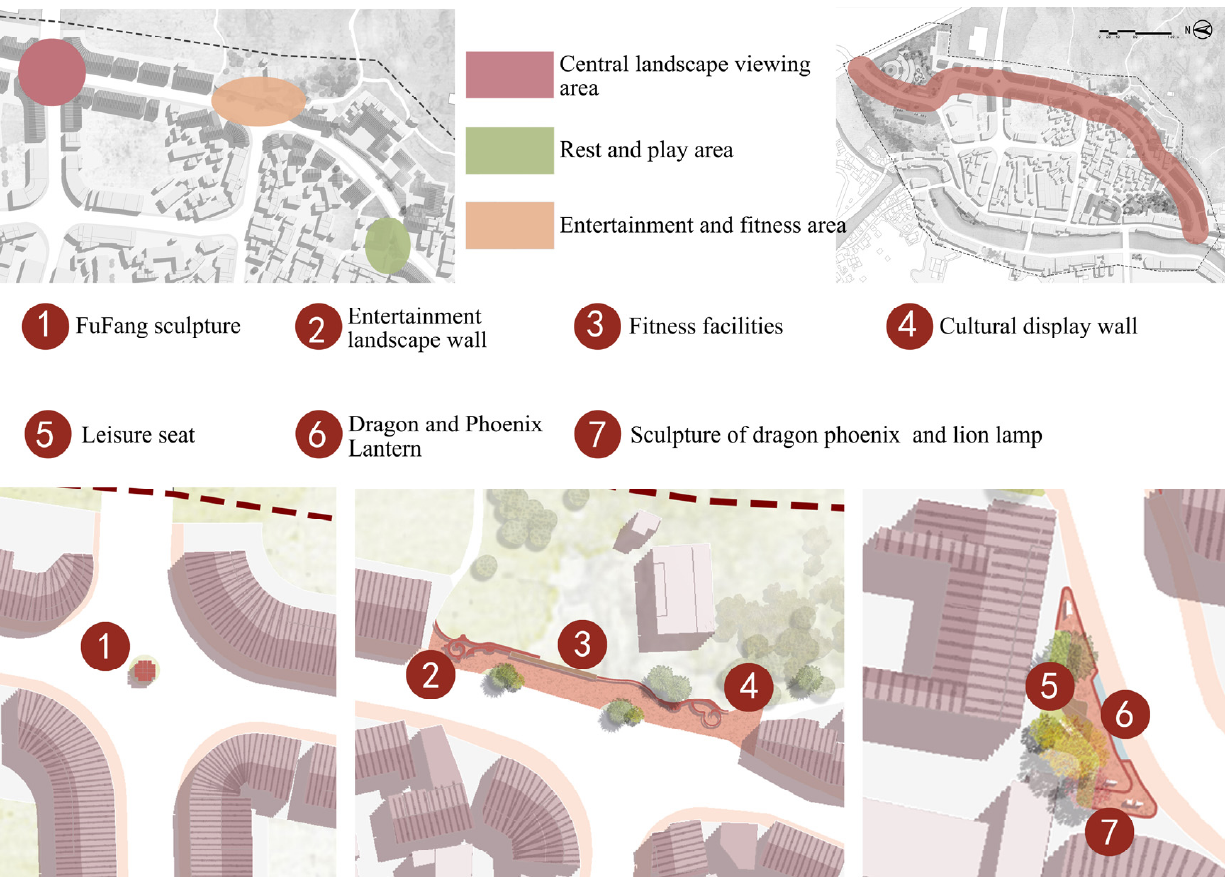
Figure 18. Plan of Hundred-family Feast culture district experience zone landscape.